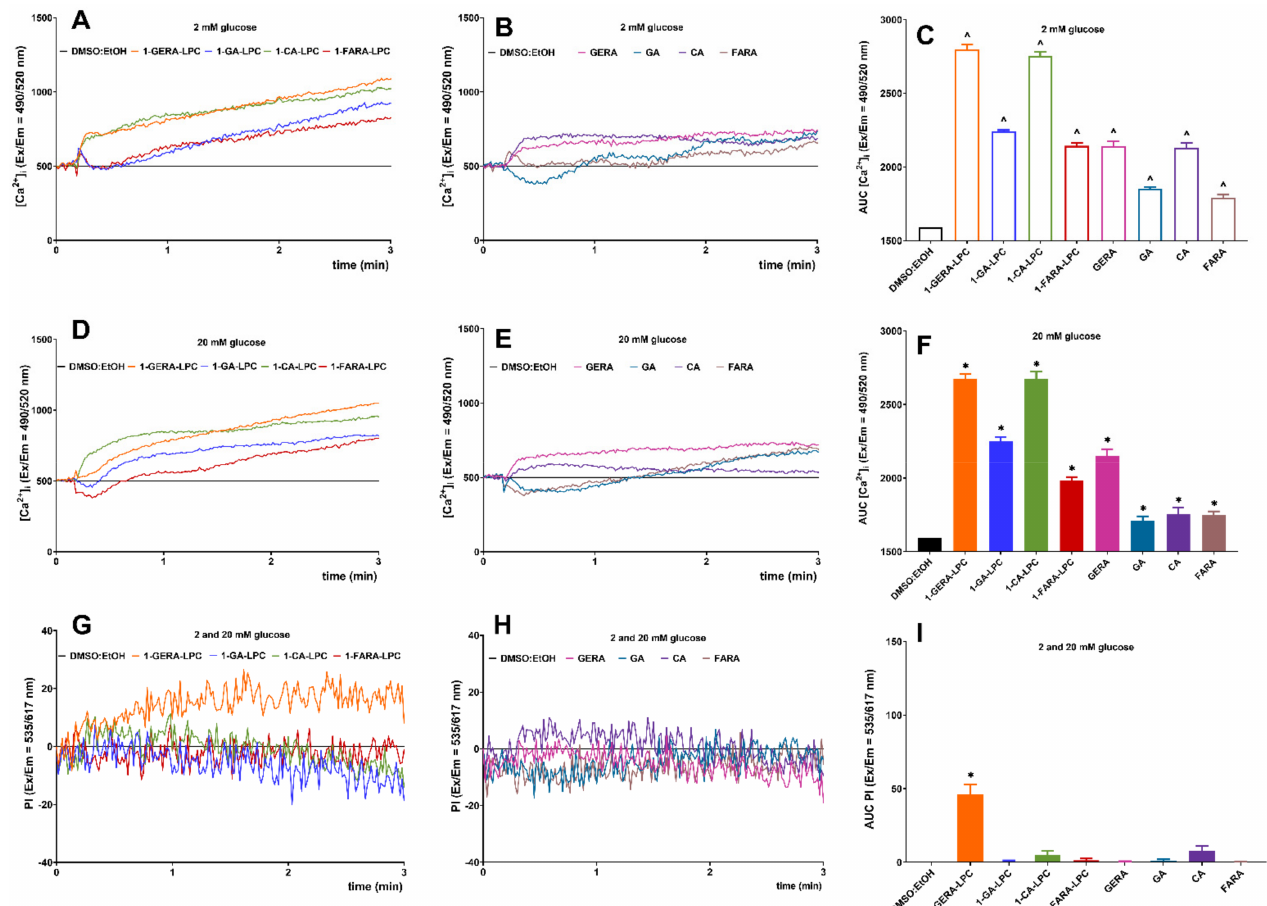
Figure 4. Intracellular Ca 2+ mobilization in MIN6 cells triggered by 1-GERA-LPC, 1-GA-LPC, 1-CA-LPC, 1-FARA-LPC and corresponding acids (GERA, GA, CA, FARA) versus the compound solvent (DMSO:EtOH) at 2 mM ( A – C ) and 20 mM glucose conditions ( D – F ), with simultaneous monitoring of membrane integrity via PI incorporation ( G – I )—data were collected from both 2 and 20 mM glucose conditions). The results are presented as the real-time kinetics of [Ca 2+ ] i and [PI] changes inside the cell during 3 min-time monitoring as well as AUC ± SEM from 3-4 independent experiments, 3-5 biological replicates each. The compounds were tested at 10 µ M concentration. p < 0.05 is considered as significantly different from DMSO:EtOH at 2 mM (ˆ) or 20 mM (*) glucose